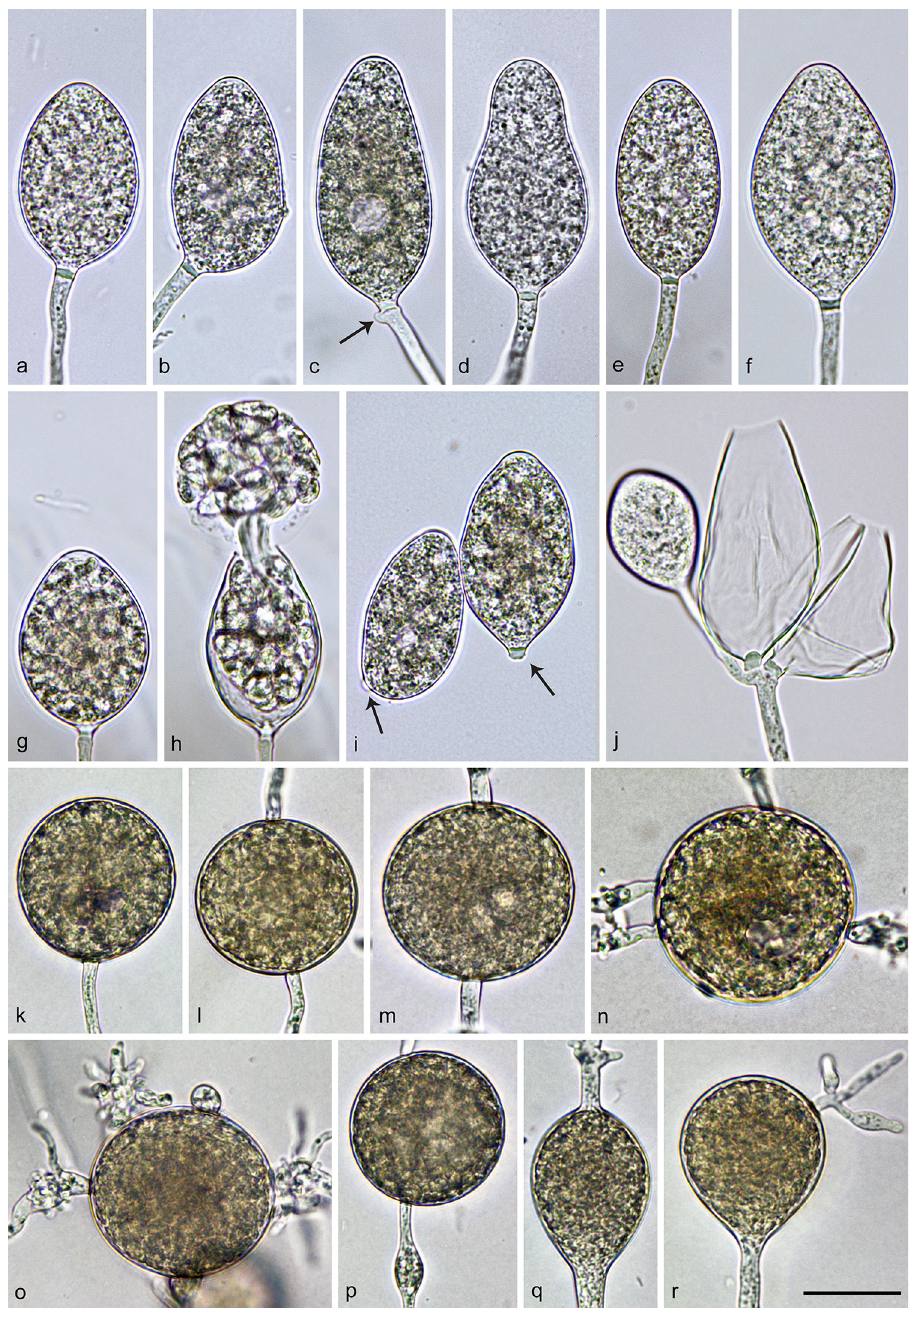
Fig 4. Morphological structures of Nothophytophthora irlandica . a–j. structures formed on V8 agar flooded with non-sterile soil extract. a–i. mature, nonpapillate, terminal sporangia with conspicuous basal plugs; a. ovoid; b. ovoid, laterally attached; c. elongated-ovoid with vacuole and beginning external proliferation (arrow); d. obpyriform; e. ellipsoid; f. limoniform; g. ovoid, before release of the fully differentiated zoospores; h. same ovoid sporangium as in g releasing zoospores; i. caducous sporangia with short pedicel–like basal plugs (arrows); j. dense sympodium with two empty sporangia after zoospore release and one immature sporangium; k–r. structures formed in solid V8 agar; k–p. globose chlamydospores; k. terminal; l–m. intercalary inserted; n–o. terminal, with radiating hyphae showing abundant production of short lateral hyphae; p. intercalary inserted with small elongated hyphal swelling; q–r. large ovoid hyphal swellings. Scale bar = 25 μ m, applies to